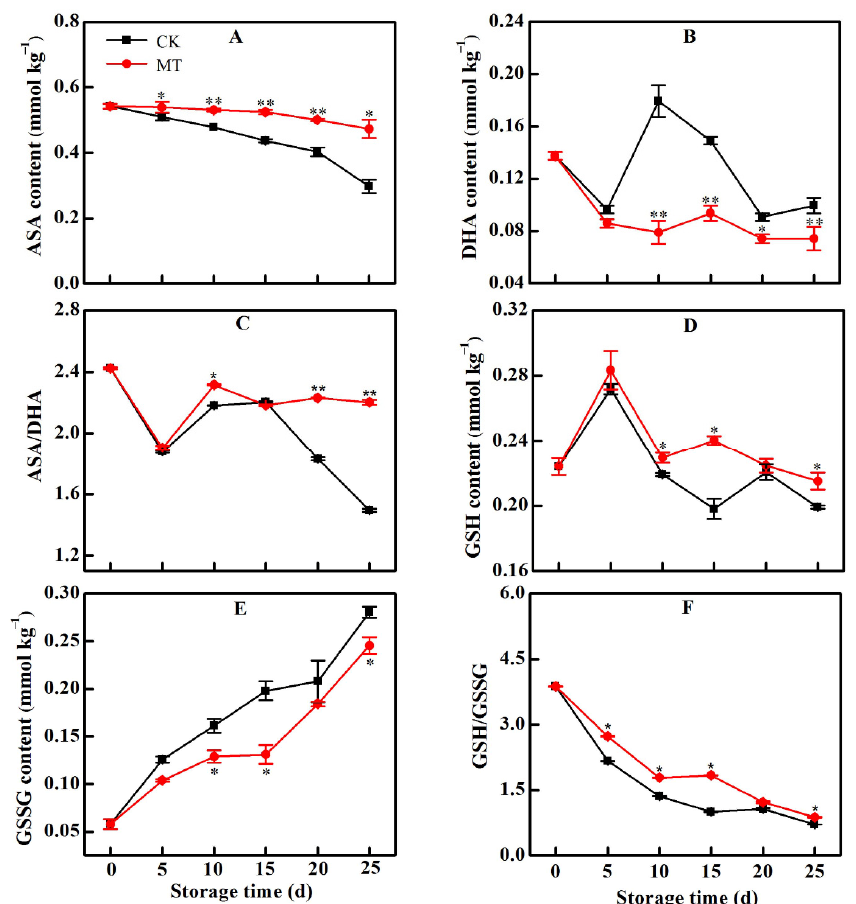
Figure 4. Change in the levels of AsA ( A ), DHA ( B ), AsA/DHA ( C ), GSH ( D ), GSSG ( E ) and GSH/GSSG ( F ) in horn pepper fruit during cold storage after treatment with water (CK) or melatonin (MT). Asterisks * and ** indicate the significant differences ( p < 0.05 or p < 0.01, respectively) between treatments.